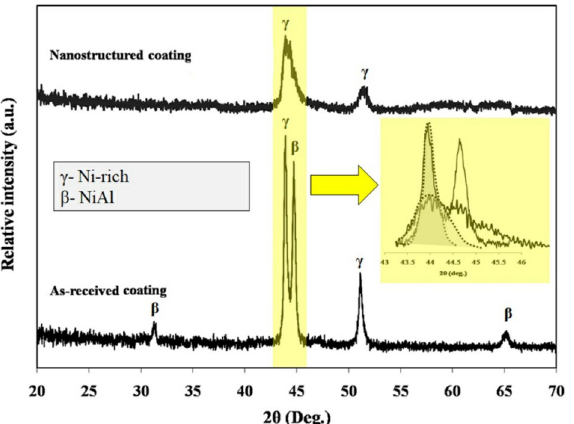
Figure 9. X-ray diffraction patterns of the as-received and nanocrystalline MCrAlY coatings applied by the HVOF spraying process.